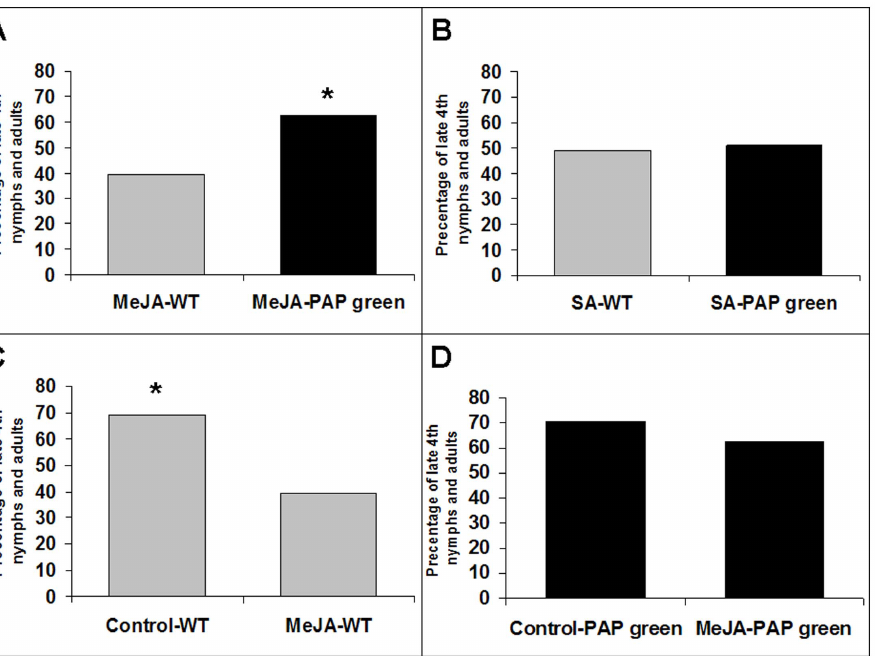
Figure 5. The proportion of progeny that had reached advanced stages of development (late 4 th nymphs and adults) by day 25 on WT (gray bars) and PAP green (black bars) plants under the three spraying regimes: SA, MeJA and control (DDW/0.015% Tween- 20). Sequential Bonferroni a priori (planned) comparisons (log-likelihood ratio test) were performed on four selected pairs, using the conservative Dunn-Sidak method. A) MeJA-WT vs. MeJA-PAP green. B) SA-WT vs. SA-PAP green. C) Control-WT vs. MeJA-WT. D) Control-PAP green vs. MeJA-PAP green. Asterisks indicate significant differences ( P # 0.05) between pairs.